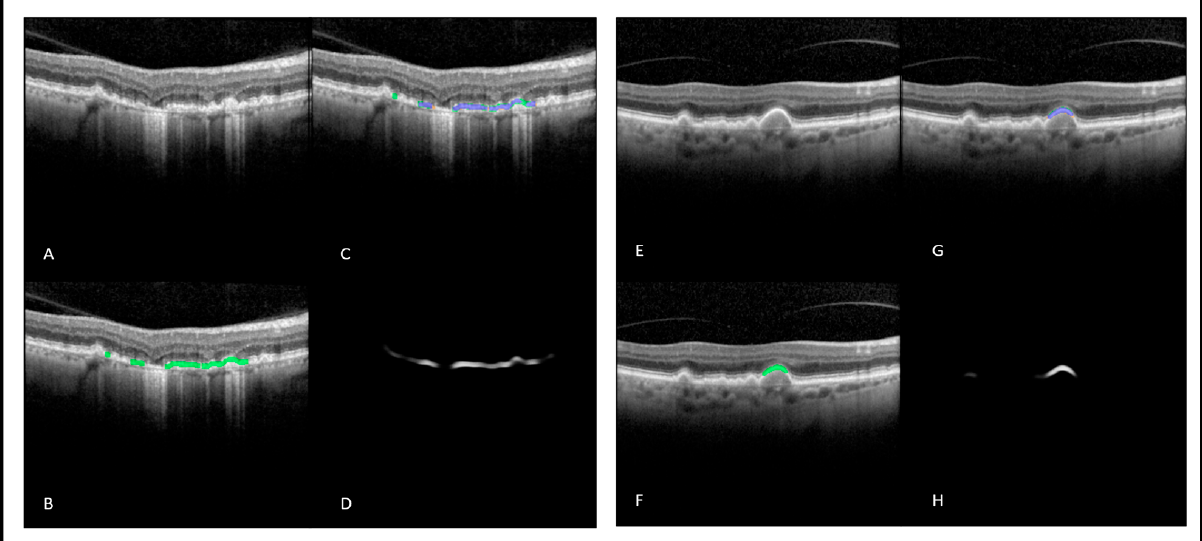
Figure 3. Output of the DL-based EZ At-Risk detection and segmentation model. ( A , E ) raw OCT B-scan; ( B , F ) OCT B-scan with ground truth EZ At-Risk mask overlay (green); ( C , G ) OCT B-scan with true positive DL output overlay (blue), false negative DL output overlay (green), false positive DL output overlay (orange); ( D , H ) DL gray scale output. DL: deep learning; EZ: ellipsoid zone; OCT: optical coherence